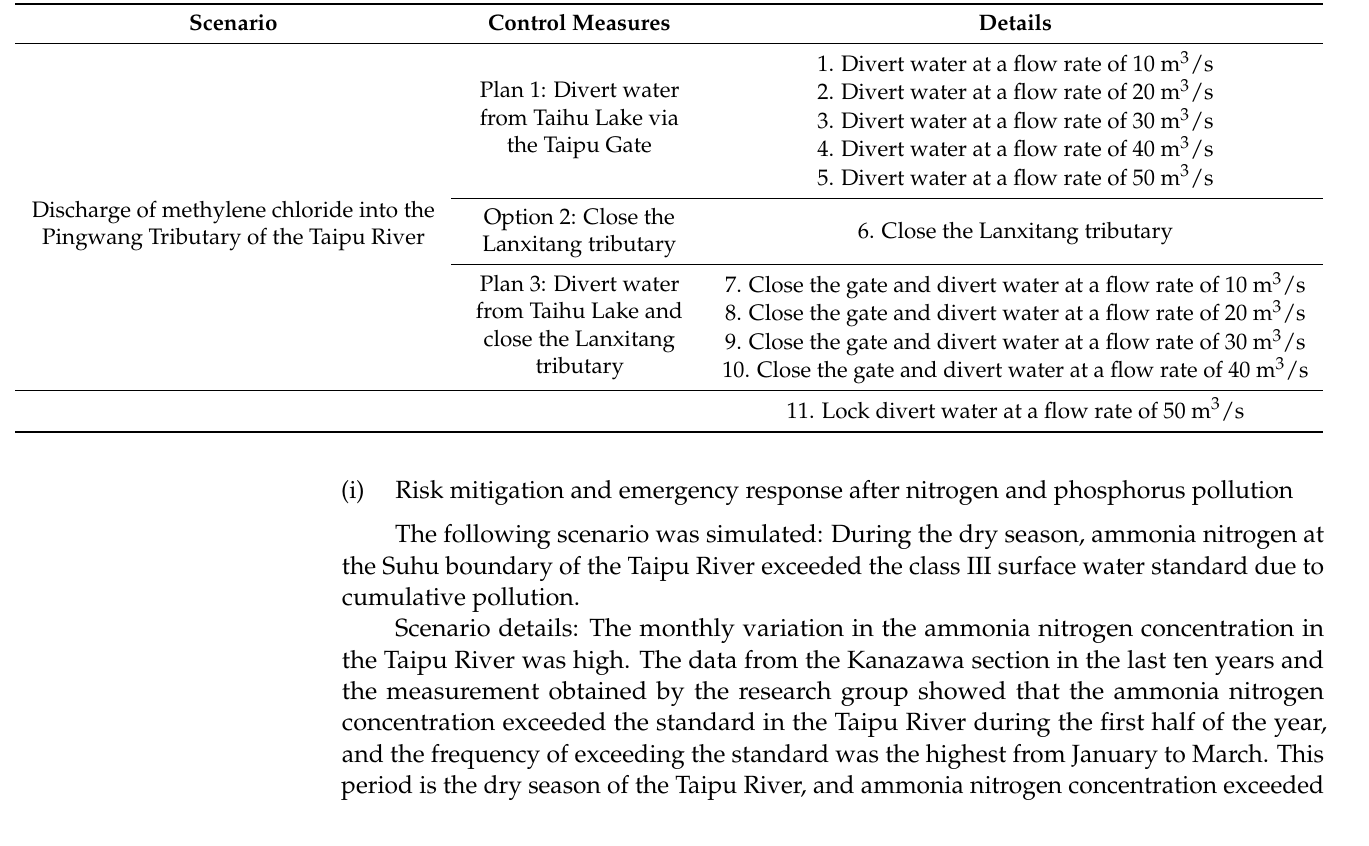
Table 9. Risk reduction and emergency response technical scheme setting for event scenario